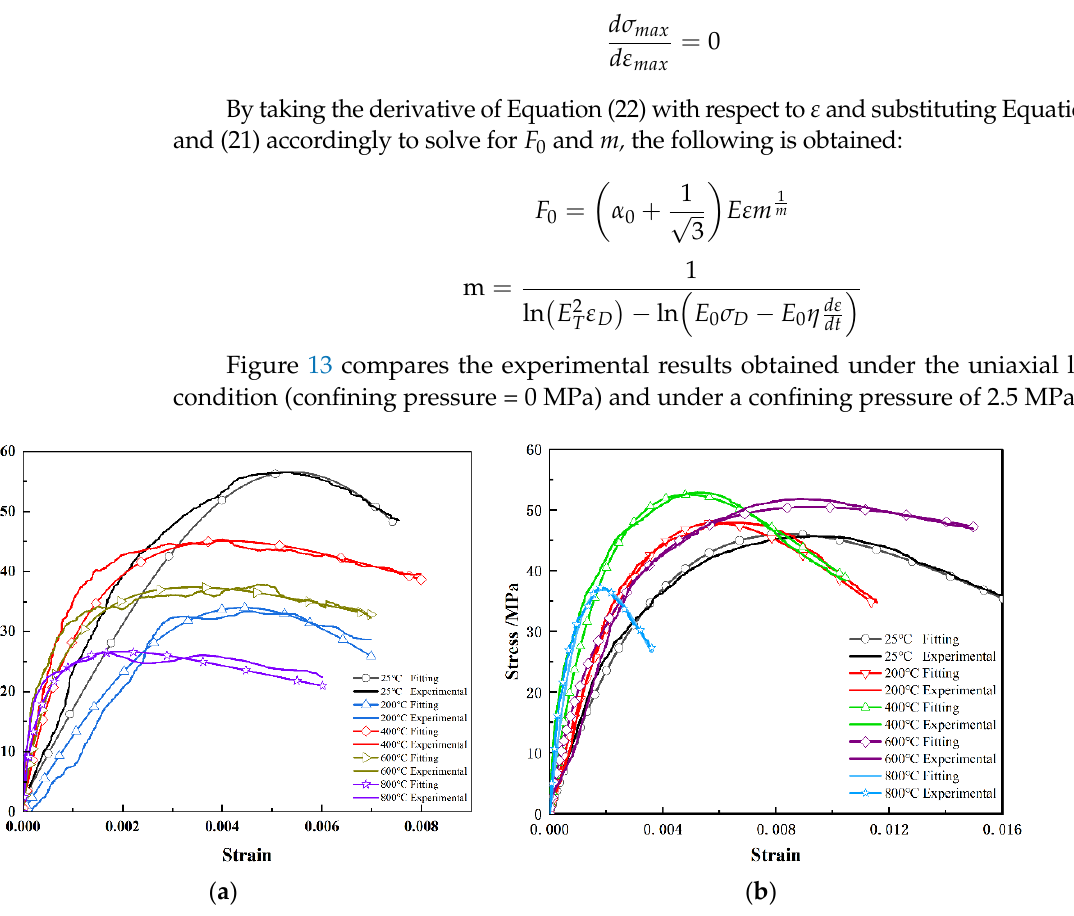
Figure 13. Fitting of the dynamic damage constitutive model. ( a ) Confining pressure = 0 MPa; ( b ) confining pressure = 2.5